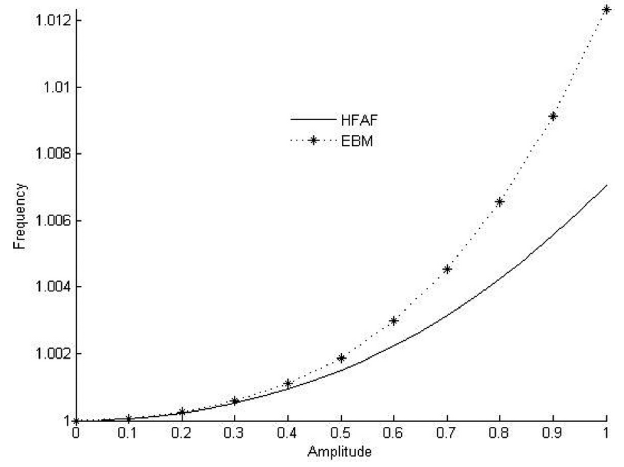
Fig. 7. The comparison between frequency-amplitude formulation and energy balance solution, when λ = 1 , for the fi rst mode.